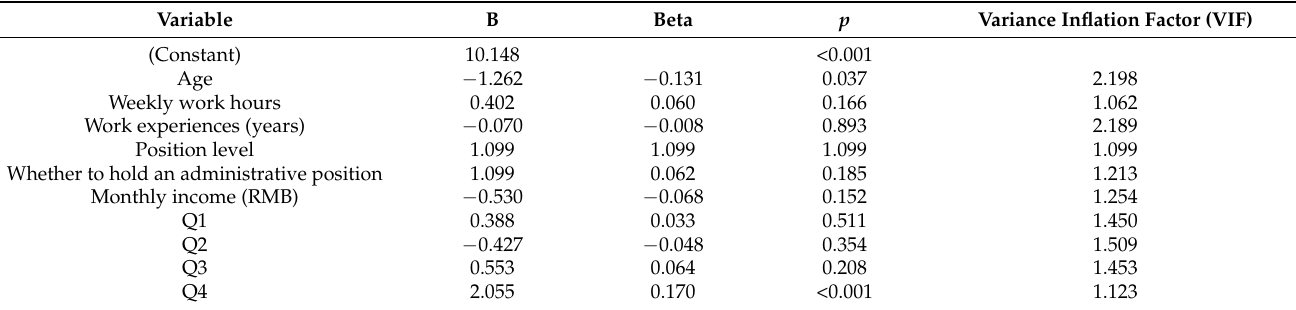
Table 8. Results of regression analysis of LPA.